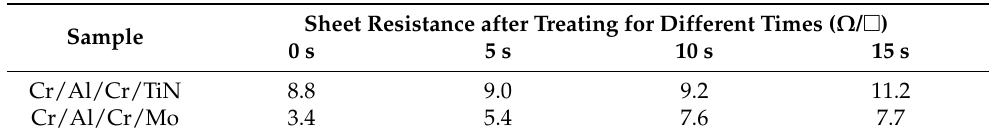
Table 1. The sheet resistance of the Cr/Al/Cr/TiN and Cr/Al/Cr/Mo anodes under the ultrasonic treatment for a different time. Sample